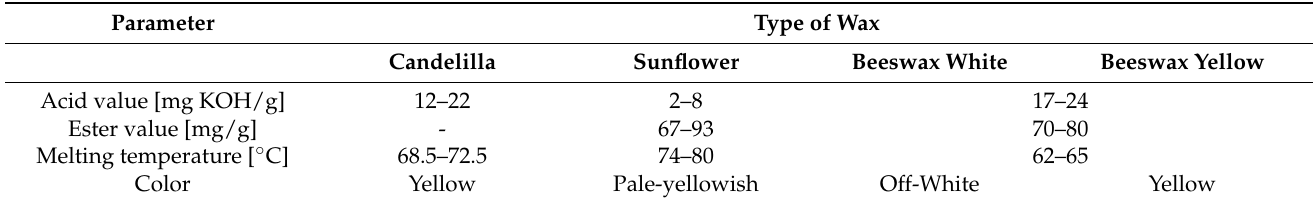
Table 1. Specification of the waxes used in the production of oleogels (manufacturer’s information). Parameter Type of Wax Candelilla Sunflower Beeswax